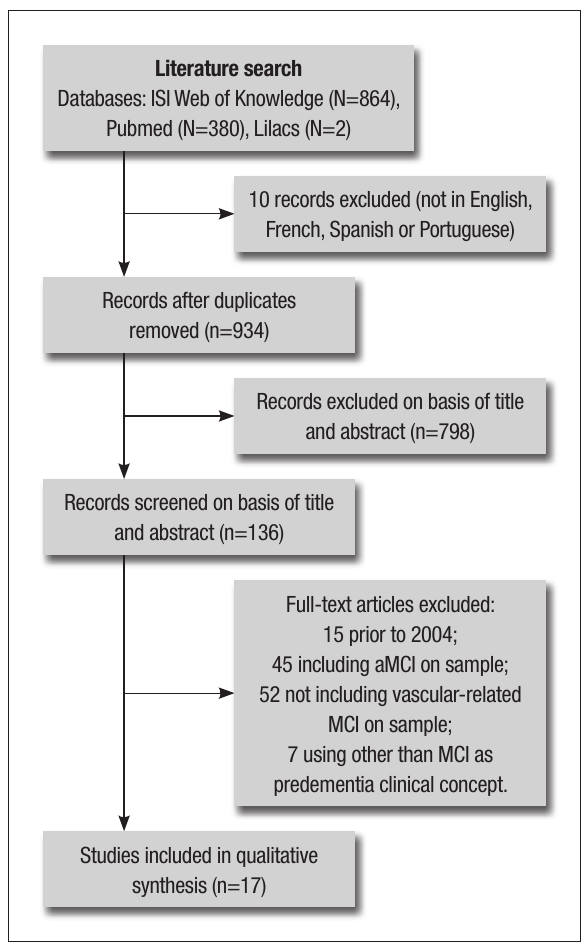
Figure 1. Flow diagram describing the systematic review of the literature on dysexecutive syndrome in vascular -related non -amnestic